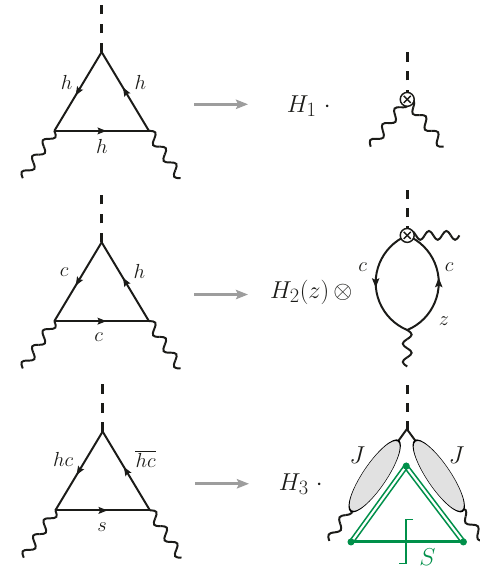
Figure 1 . Leading regions of loop momenta ( h : hard, c : n 1 -collinear, s : soft, hc : n 1 -hard-collinear, hc : n 2 -hard-collinear) contributing to the decay amplitude. The convolution symbol ⊗ in the second term means an integral over z